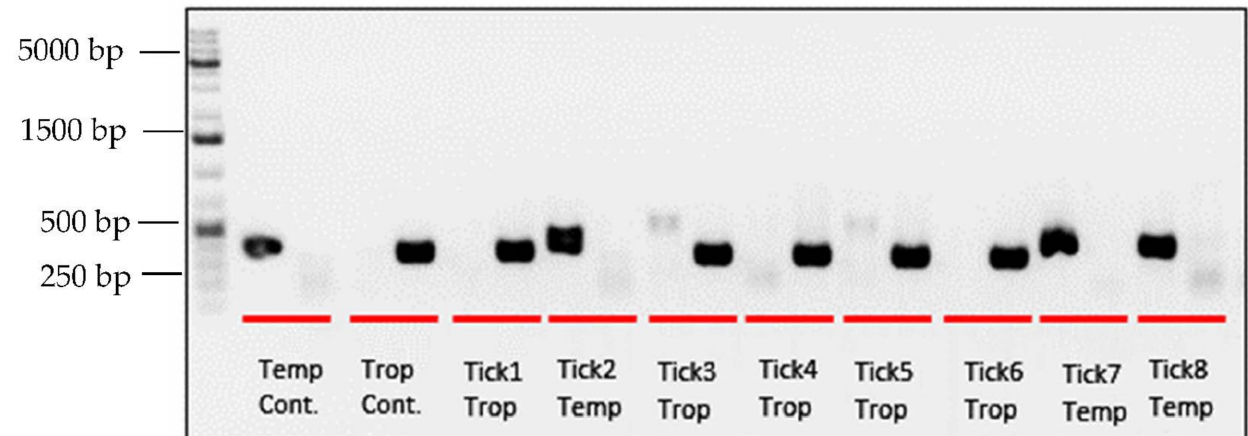
Figure 2. R. sanguineus s.l. lineage-specific gel electrophoresis. Red lines delineate reactions using the temperate (left) and tropical (right) primers for each sample. The first sample on the left is a temperate control, with a band from the temperate primer but not the tropical.